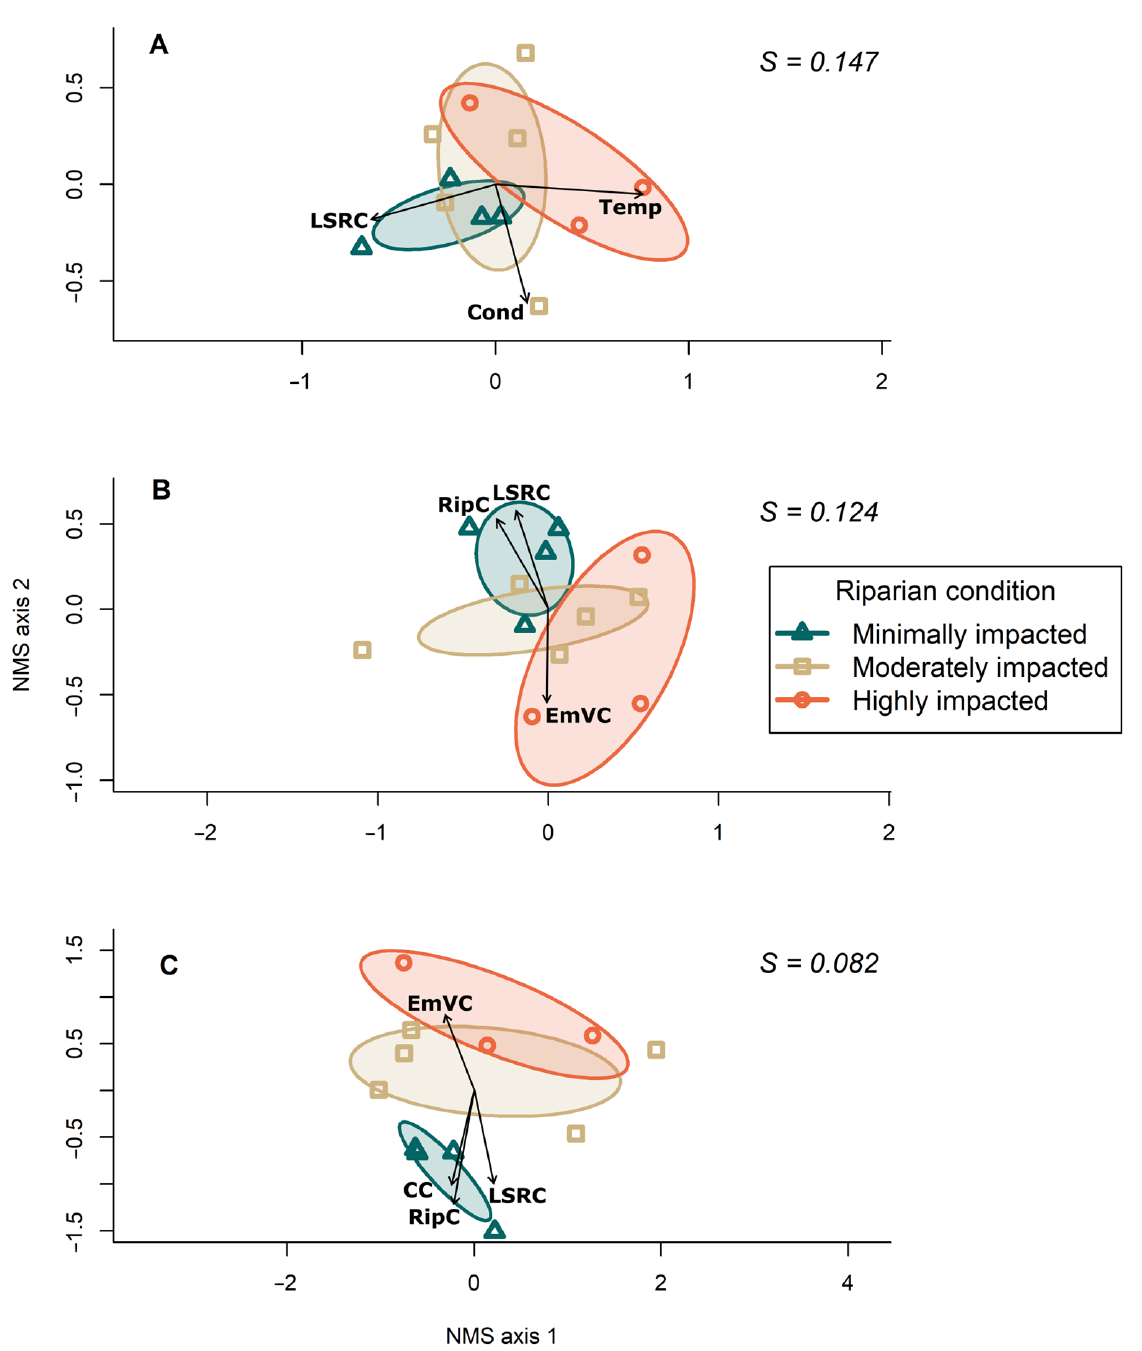
Figure 3. NMS ordination bi-plots plotting sites according to their: ( A ) riffle assemblage, ( B ) insect- only riffle assemblage and ( C ) odonate assemblage. Ninety-five percent confidence ellipses are plotted for minimally, moderately and highly impacted sites. Vectors represent environmental variables that significantly ( p < 0.1) correlated with each ordination after running permutation tests ( n = 9999 permutations). Vector length is proportional to the correlation between the environmental variable and the ordination. Abbreviated variables are local riparian conditions (RipC), landscape riparian conditions (LSRC), canopy cover (CC), emergent vegetation cover (EmVC), temperature (Temp) and conductivity (Cond). Stress ( S ) is reported for each